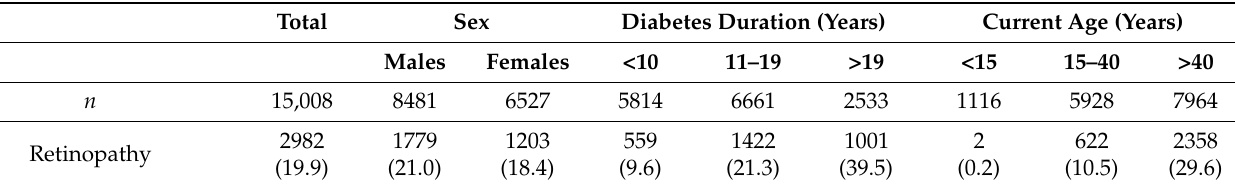
Table 2. Prevalence n (%) of diabetes-related micro- and macro-vascular complications, as assessed by ICD code records and laboratory data according to sex, diabetes duration, and current